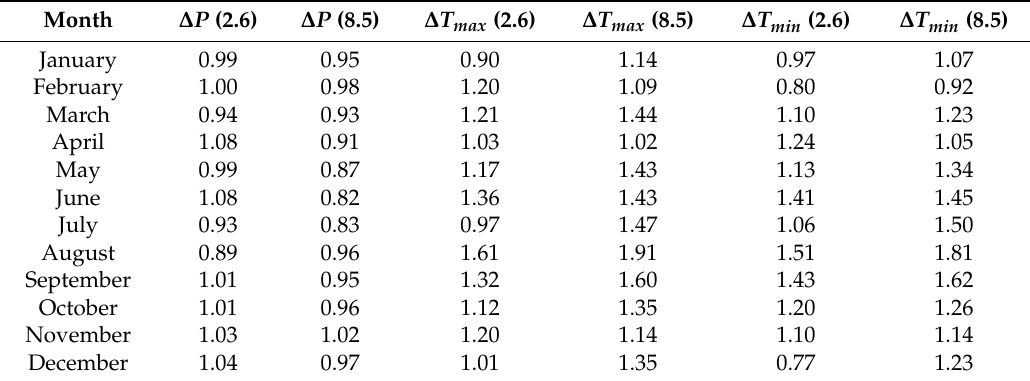
Table 1. Median of precipitation and maximum and minimum temperature for RCP 2.6 and RCP 8.5 scenarios for each month.